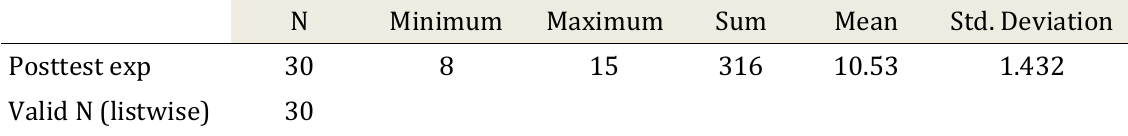
Table 4.16 The Mean Score of Students' Posttest in Class Experimental